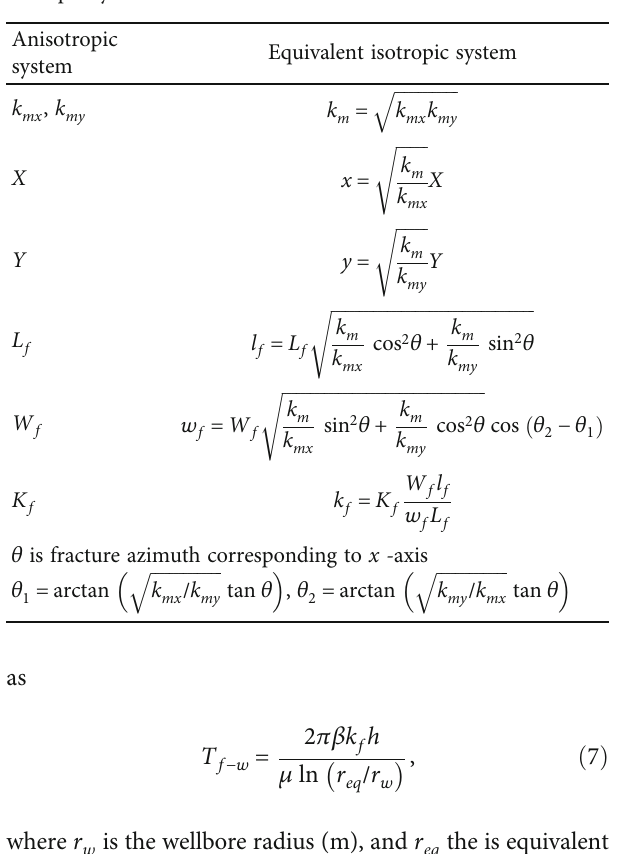
Table 1: Conversion of the anisotropic system to the equivalent isotropic